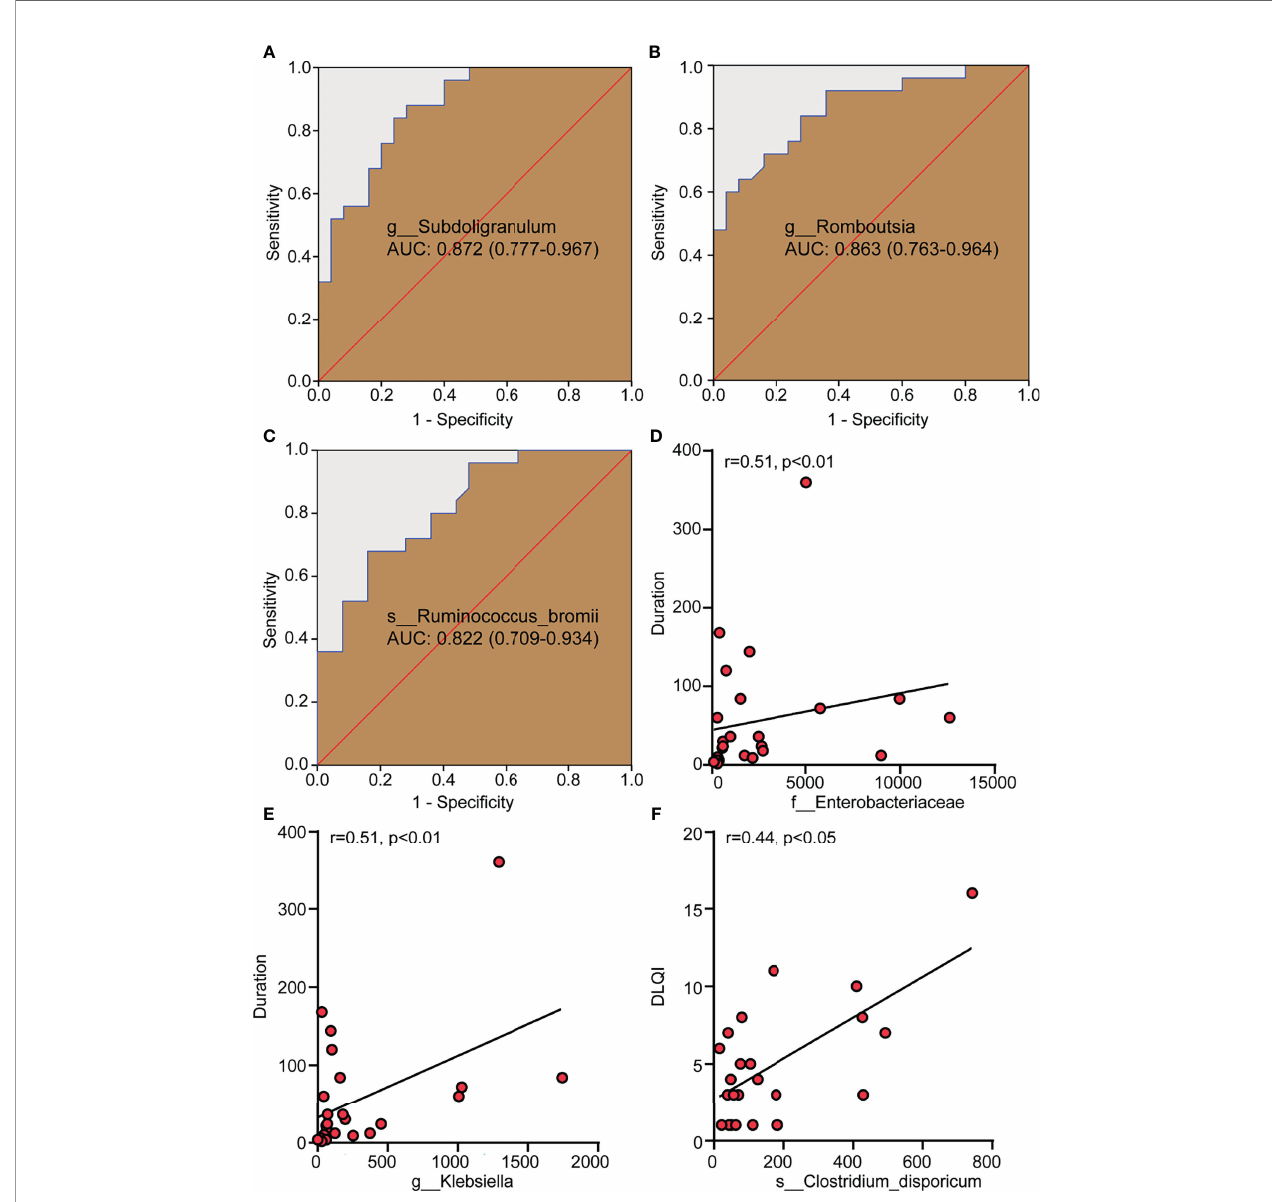
FIGURE 3 | Differentialbacteriawithadiagnosticvaluefor CSDandgutmicrobiotataxawithacorrelationwithclinicalparameters. (A – C) Thepotentialvalueofthereceiver operating characteristiccurve(ROC)analysisbasedonthebacterialOTUnumberfor correctdiagnosisofCSD. (D,E) ThepositivecorrelationbetweenEnterobacteriaceaeand KlebsiellaandthedurationofCSD. (F) The positivecorrelationbetween Clostridium dispericum andDLQI. r, relatedcoef fi cient;.NC,normalcontrol; CSD, chronicspontaneous urticariaandsymptomaticdermographism; AUC,area under thecurve,expressedas AUC value+95% con fi denceinterval; DLQI, dermatologylife